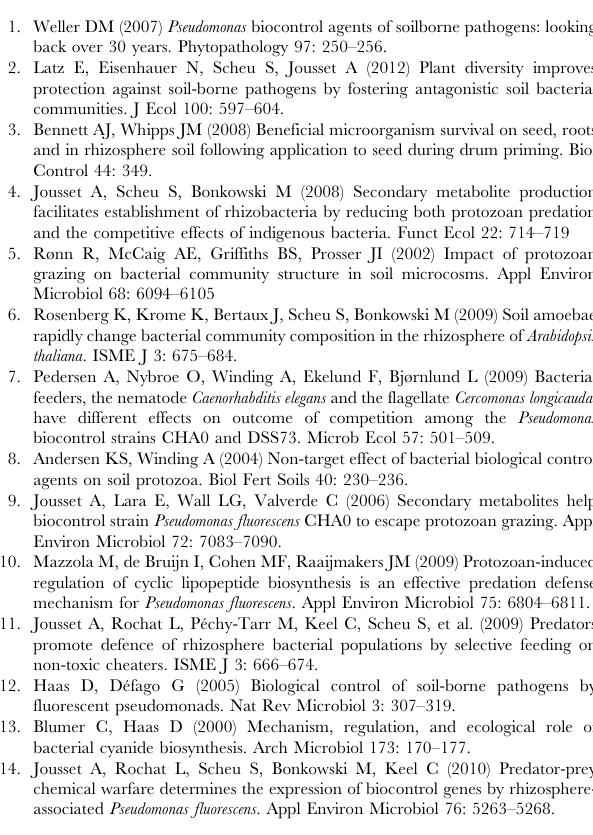
Time (days) Amoebae Isolates screened Isolates carrying biocontrol genes for Isolates